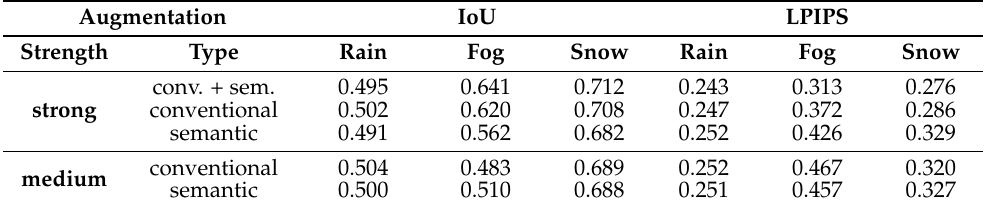
Table 3. Testing on different augmentation categories